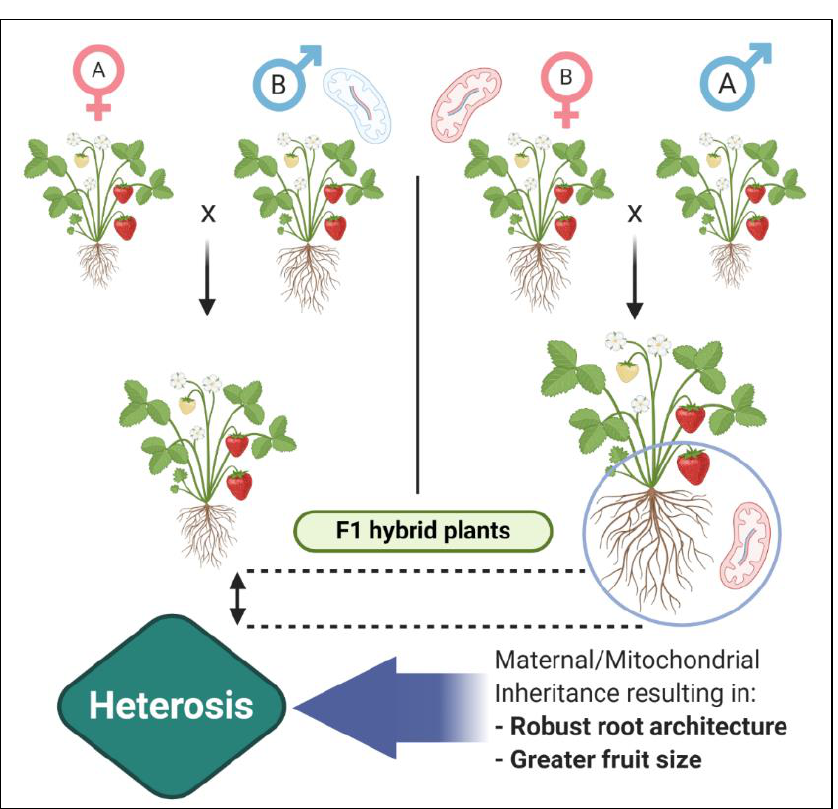
Figure 5. Hybrid vigor and maternal (mitochondrial) inheritance.